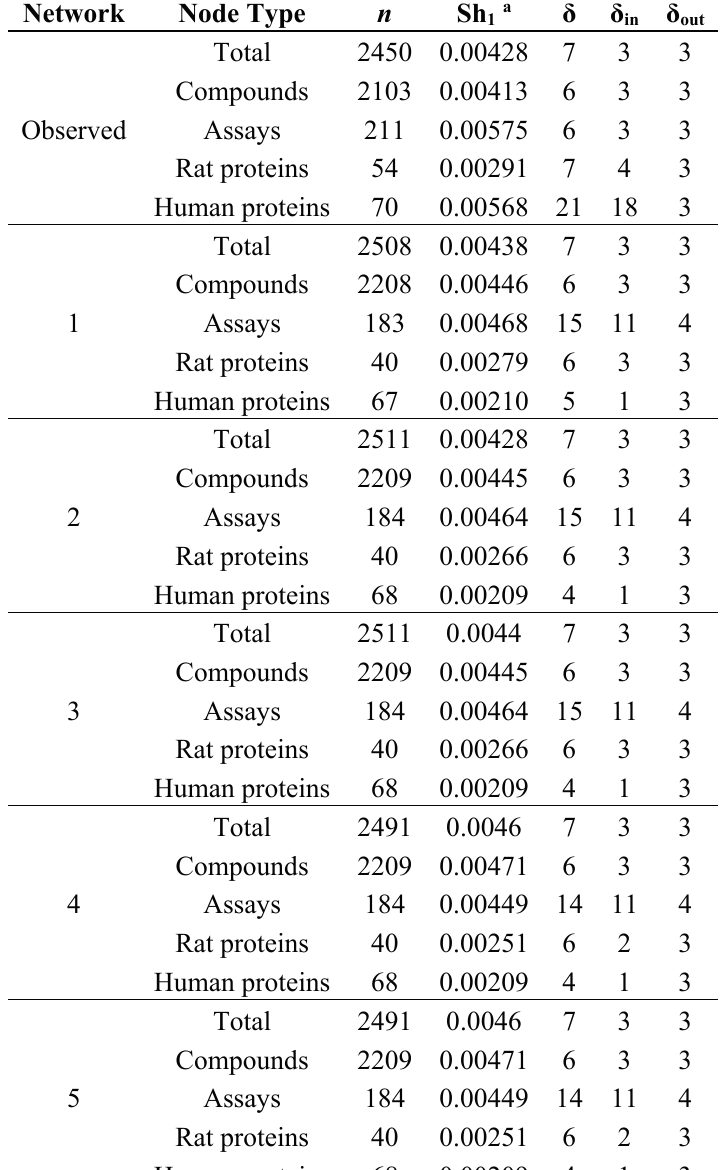
Table 4. Topological properties of CHEMBL complex networks predicted with ALMA-entropy